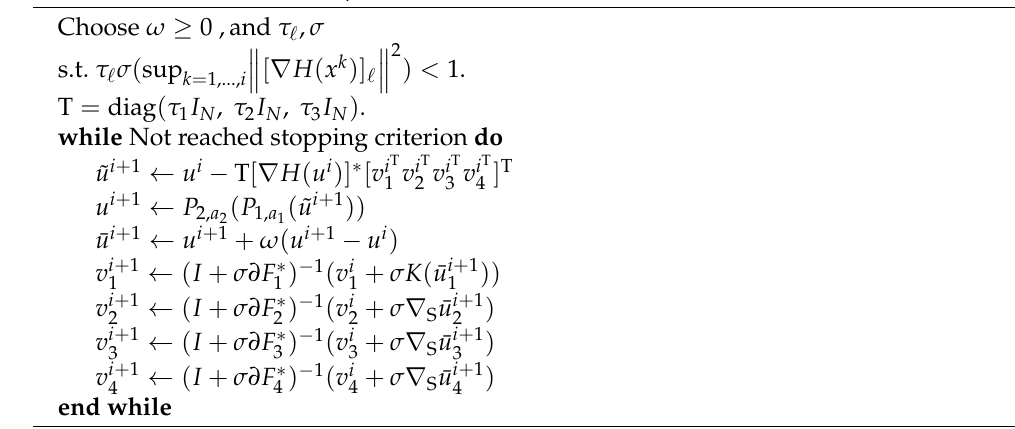
Algorithm A1 Embedded T 1 ρ with NL-PDPS, adapted from [17] [Algorithm